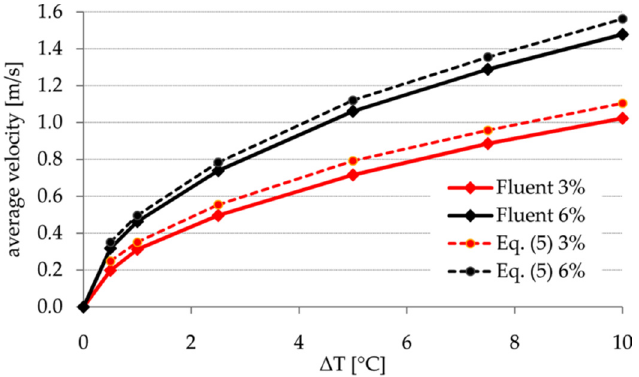
Figure 12. Average airflow longitudinal velocity for selected temperature differences between tunnel walls and external temperature.